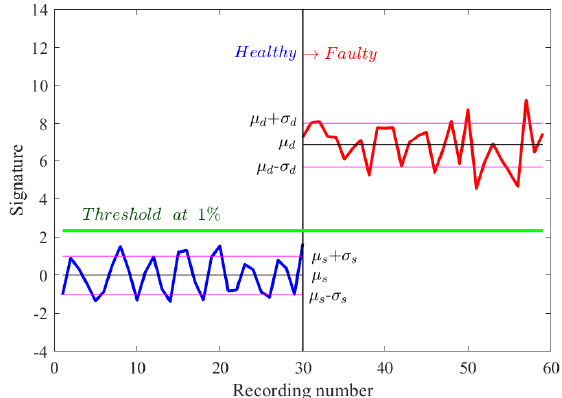
Figure 16. Fault signatures using 30